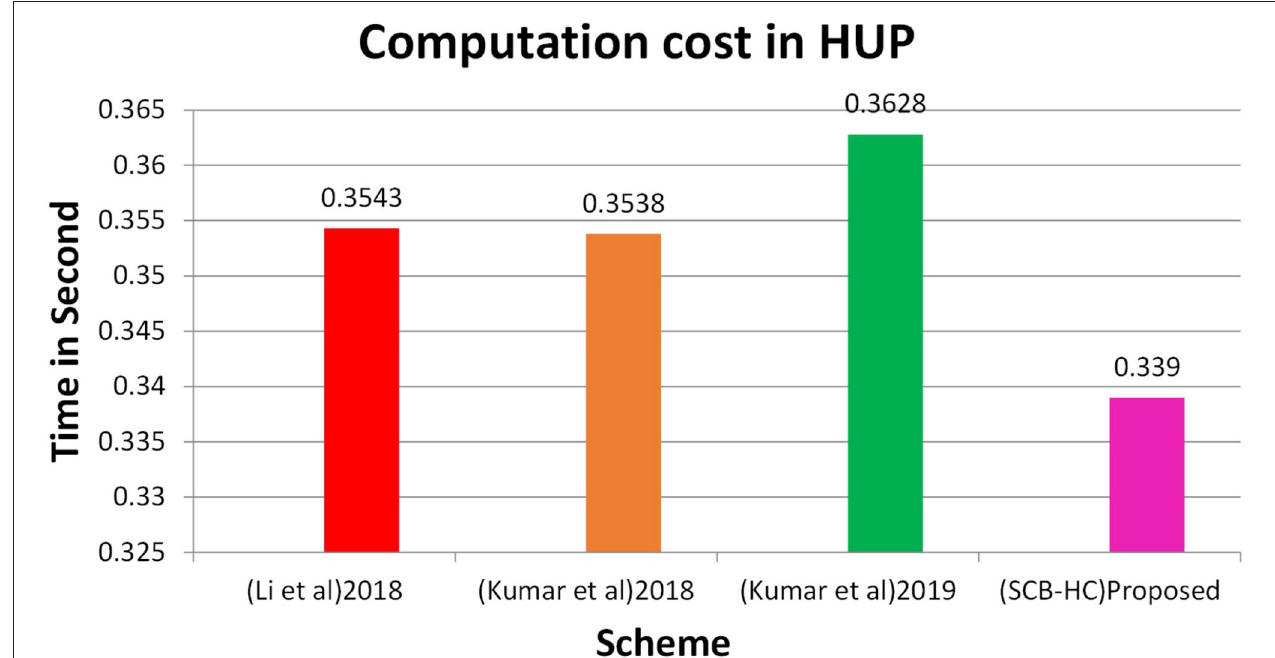
FIGURE 2 | HUP computation cost.